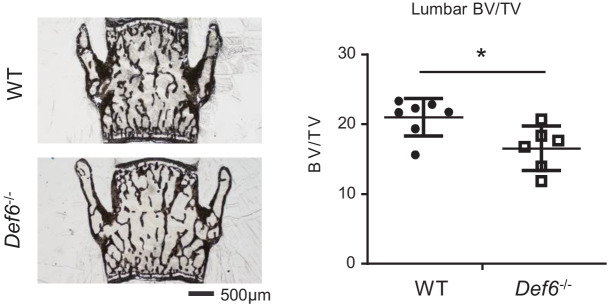
Def6 exhibits osteoporosis in lumbar bones.(A) Images of Von Kossa staining of lumbar from WT and Def6-/- mice. (B) Bone morphometric analysis of bone volume/tissue vol (BV/TV) of lumbar from WT and Def6-/- male mice. n = 6. Data are mean ± SEM. **p<0.01.Figure 2—figure supplement 1—source data 1.Source data for Figure 2—figure supplement 1.